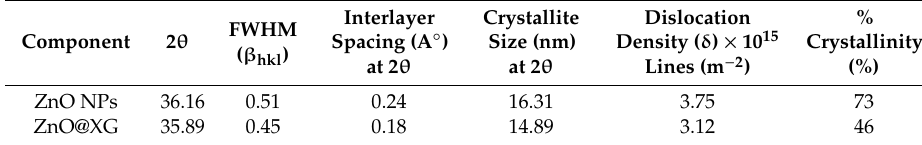
Table 1. XRD parameters ZnO and ZnO@XG nanocomposite.